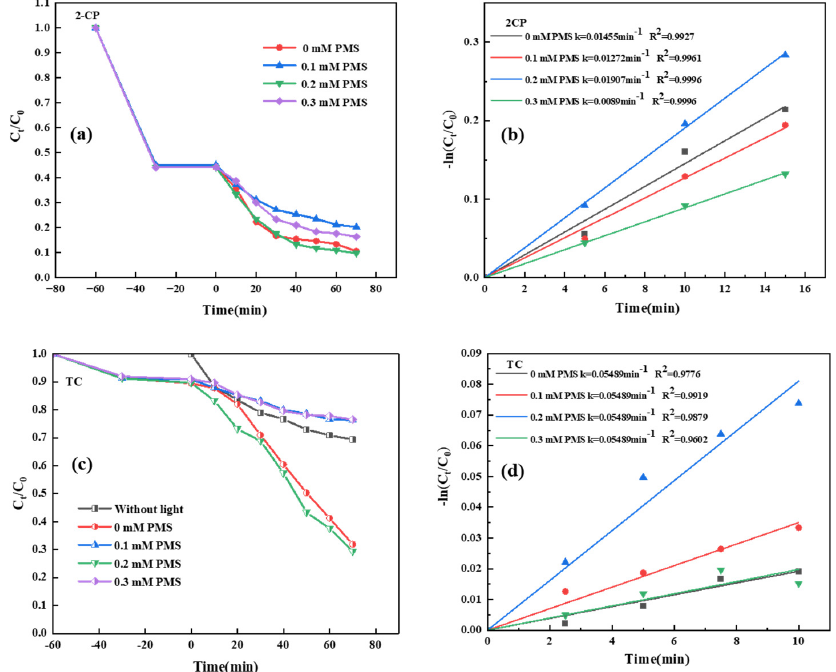
Figure 10. Photocatalytic contaminant removal curves and kinetic fitting curves for ZIF-8 activated PMS. ( a ) Degradation and ( b ) The kinetic fittings of 2-CP. ( c ) Degradation and ( d ) The kinetic fittings of TC.